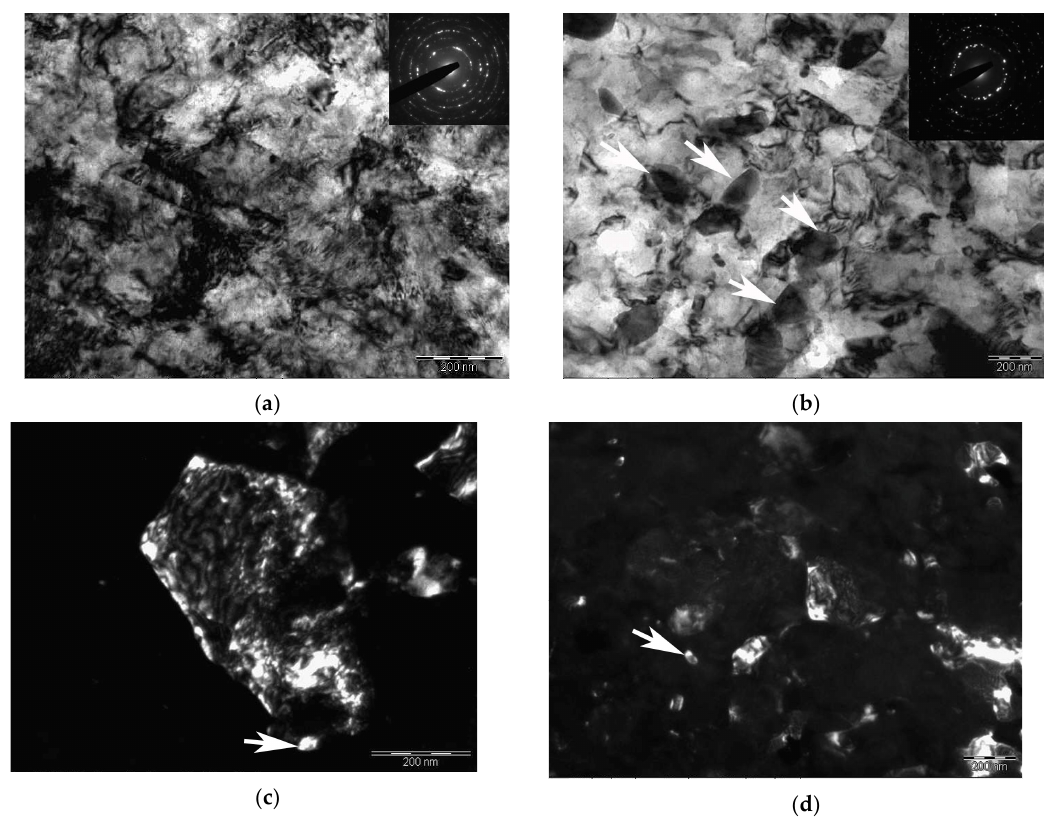
Figure 3. Bright-field TEM images of Grade 91 microstructure: ( a ) after T500 + HPT300; ( b ) after T800 + HPT300, where the arrows show carbides M 23 C 6 ; dark-field TEM images of Gra d e 91 microstructure ( c ) TEM after T500 + HPT300 where the arrows show carbides M 23 C 6 ; ( d ) after T800 + HPT300 where the arrows show carbonitrides.